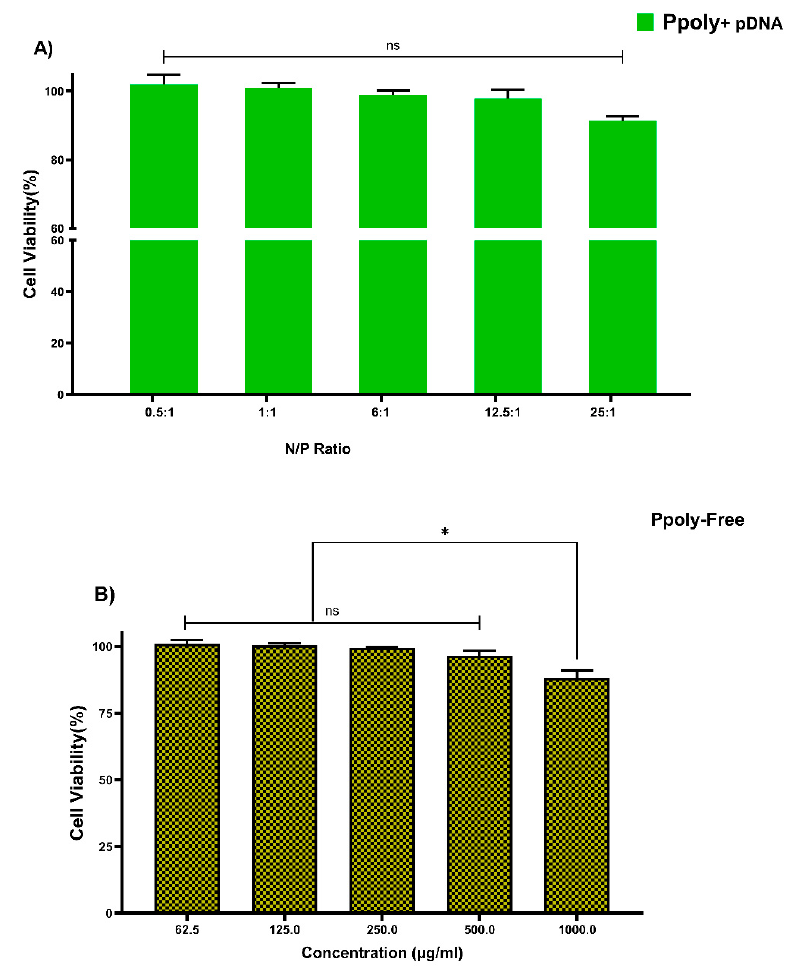
Figure 4. Measuring the viability of HT-29 cells using MTT assay in a 2D culture system after 24 h. ( A ) PPoly in complexes with pDNA at different N/P ratios. ( B ) free PPoly at concentrations 62.5 to 2000 µg/mL. One-way ANOVA with Tukey post hoc analysis was performed. * p < 0.05 and ns